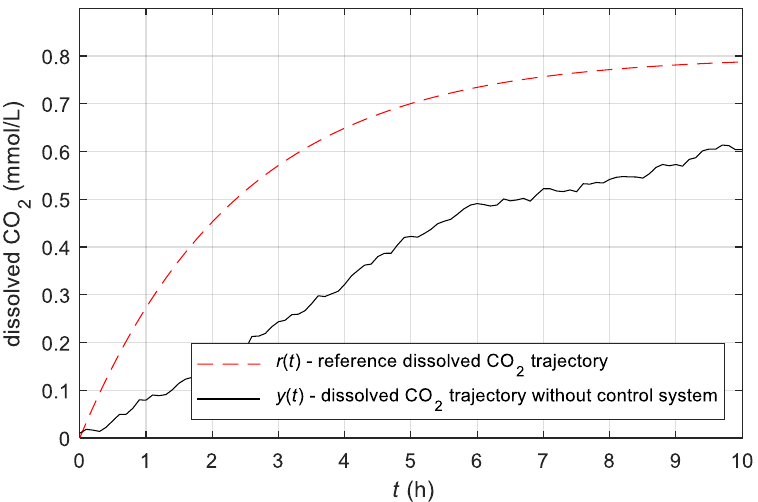
Figure 8. The trajectory of the dissolved CO 2 of the modified fermentation process in batch bioreactor without a control system (solid line) and the reference trajectory of the dissolved CO 2 of the batch bioreactor (dashed line); data of the modified fermentation process with inactivated kefir grains are shown in Table 3, and the reference trajectory is described in Equation (20).